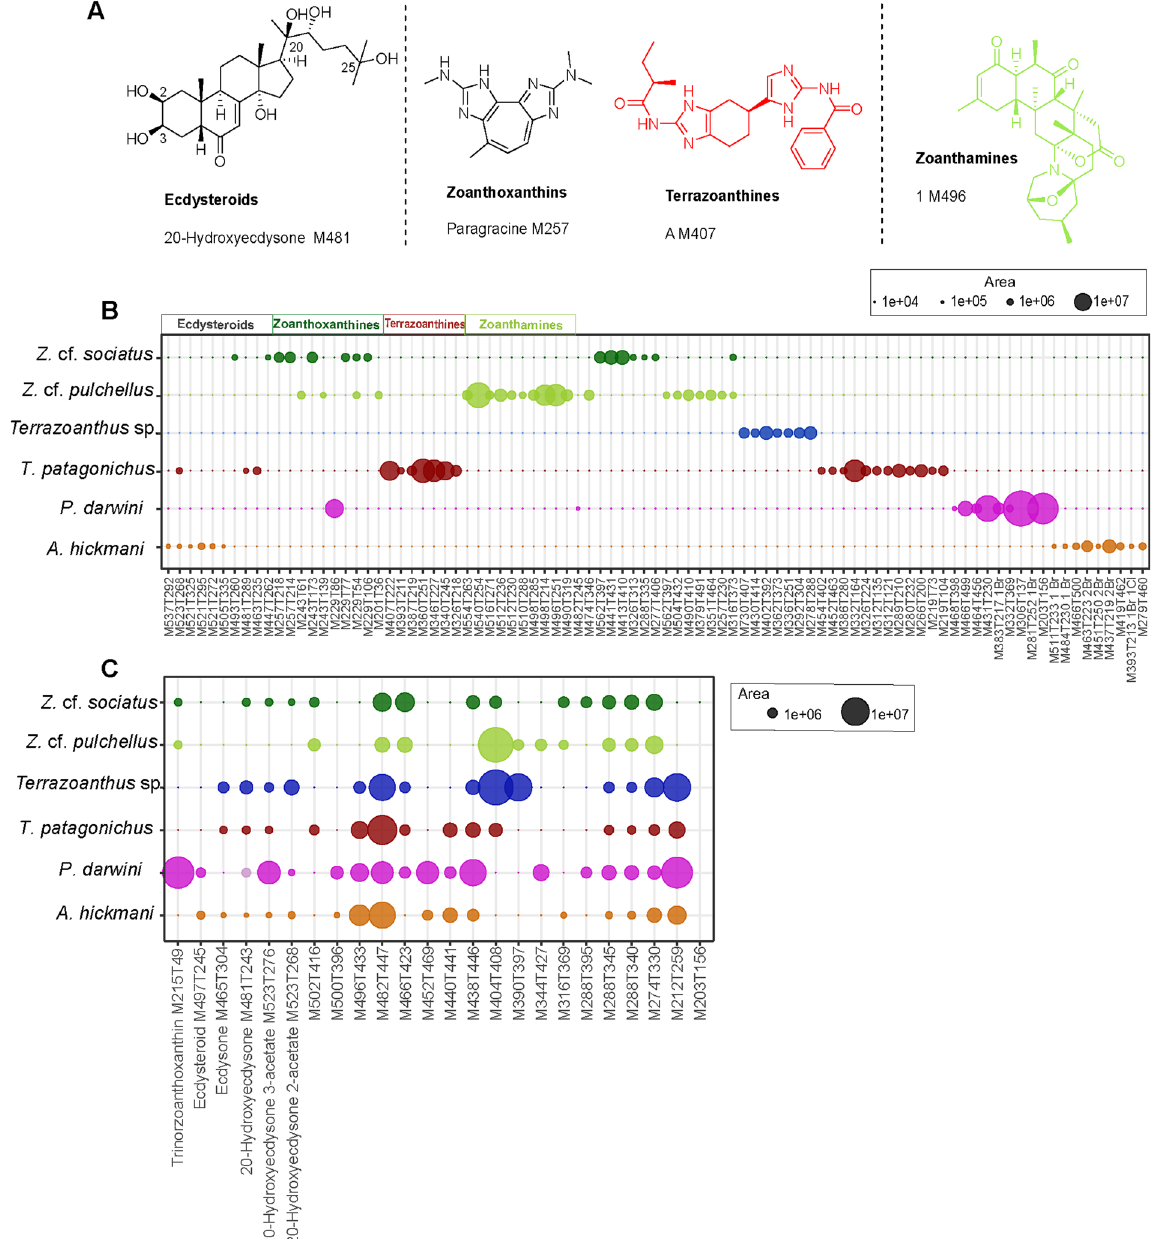
Figure 4. ( A ) Chemical structure of the major metabolite markers (areas ≥ 10 6 ) of the six zoantharian species studied. ( B ) Main variables found in only one species of zoantharian. ( C) Main variables found in more than one species of zoantharian. For each variable M = molecular weight, T = retention time. Different colors represent the six different zoantharians